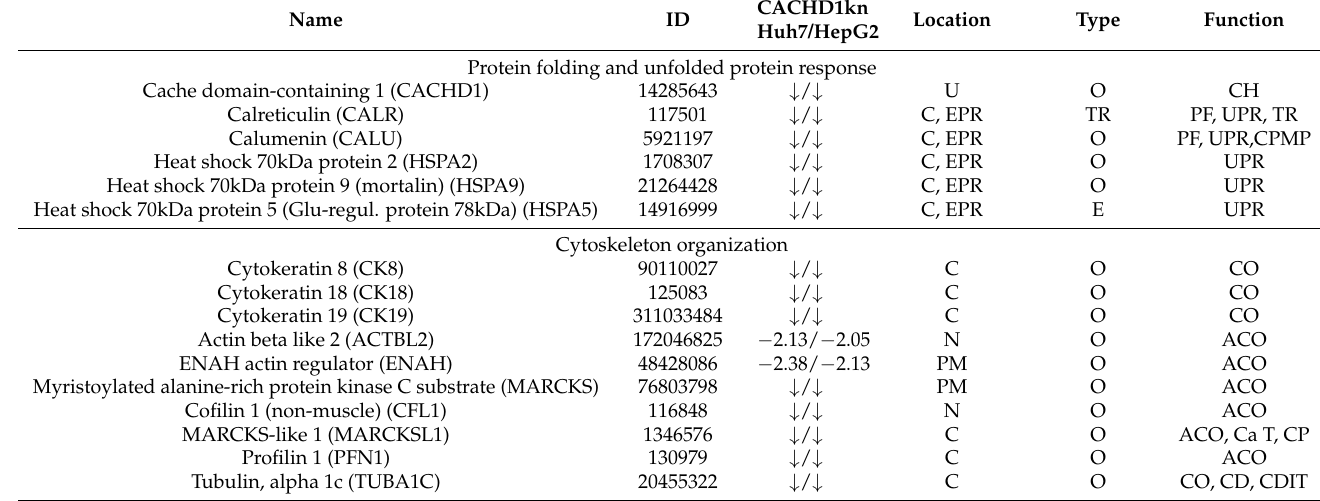
Table 4. Proteins with significantly inhibited expression in CACHD1 kn Huh7 and HepG2 liver cancer